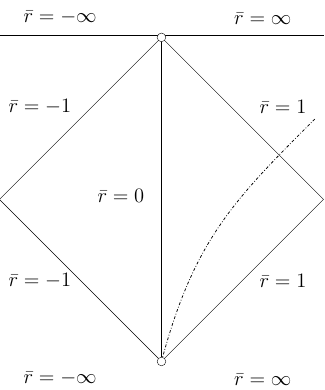
Figure 1 . The Penrose diagram of the two-dimensional de Sitter spacetime. The dot-dashed curve represents an imaginary surface of the matter of the gravitationally